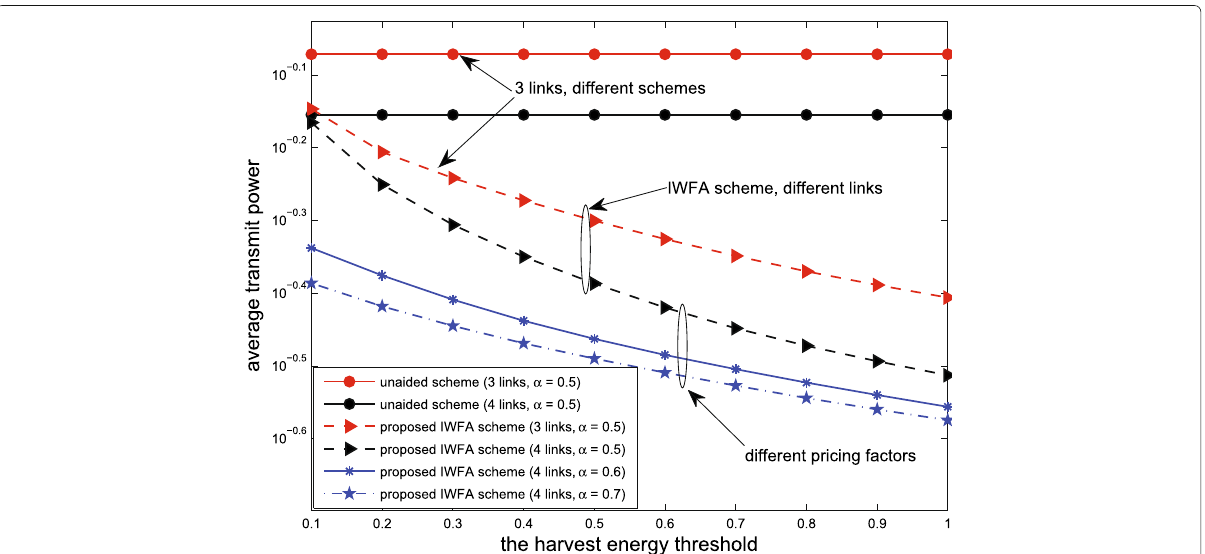
Fig. 4 The average transmit power as a function of the harvest energy threshold. Figure 4 shows the results of the average transmit power versus the harvest energy threshold. The different types of lines represent the proposed IWFA scheme and the unaided scheme under different conditions of K ∈ { 3,4 } and α ∈ { 0.5,0.6,0.7